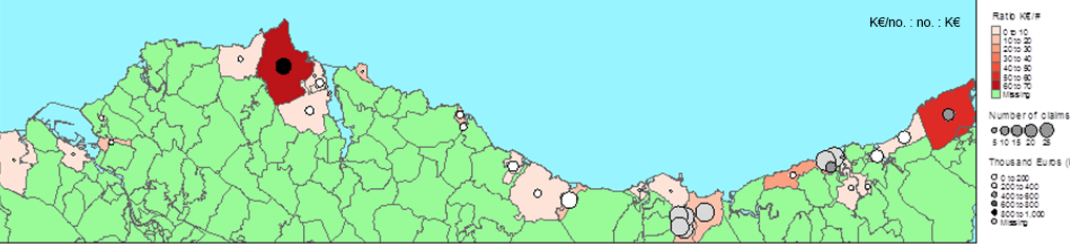
Figure 7. KC / #, #, KC spatial distribution.